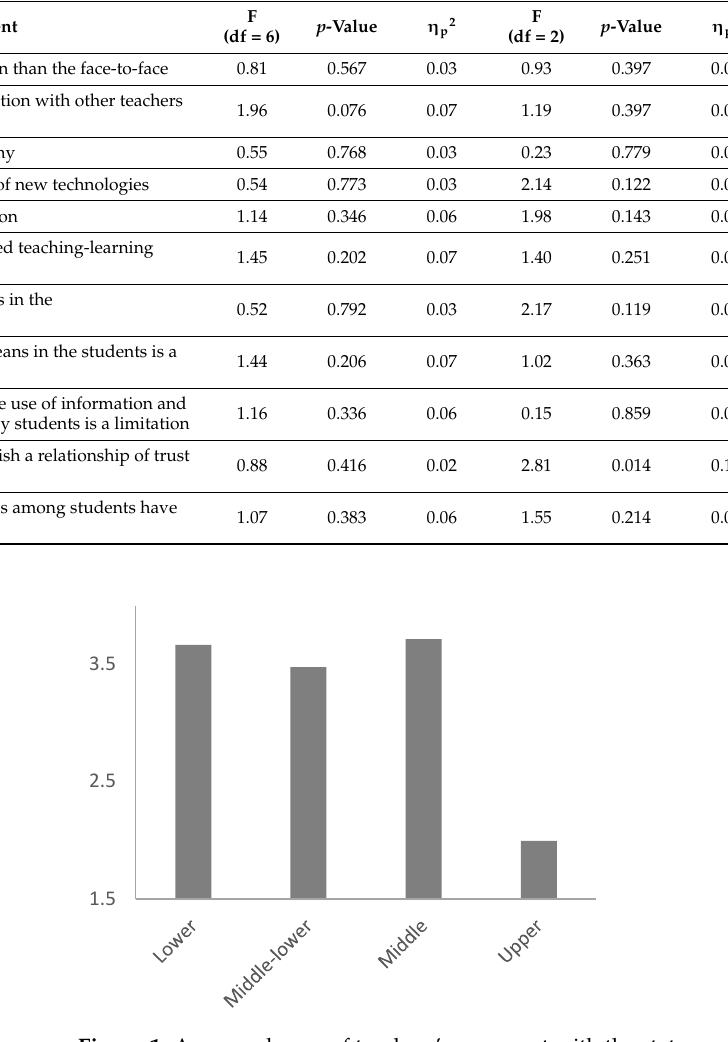
Figure 1. Average degree of teachers’ agreement with the statement “It is more difficult to establish a relationship of trust with the student”, according to the socio-economic status of students.